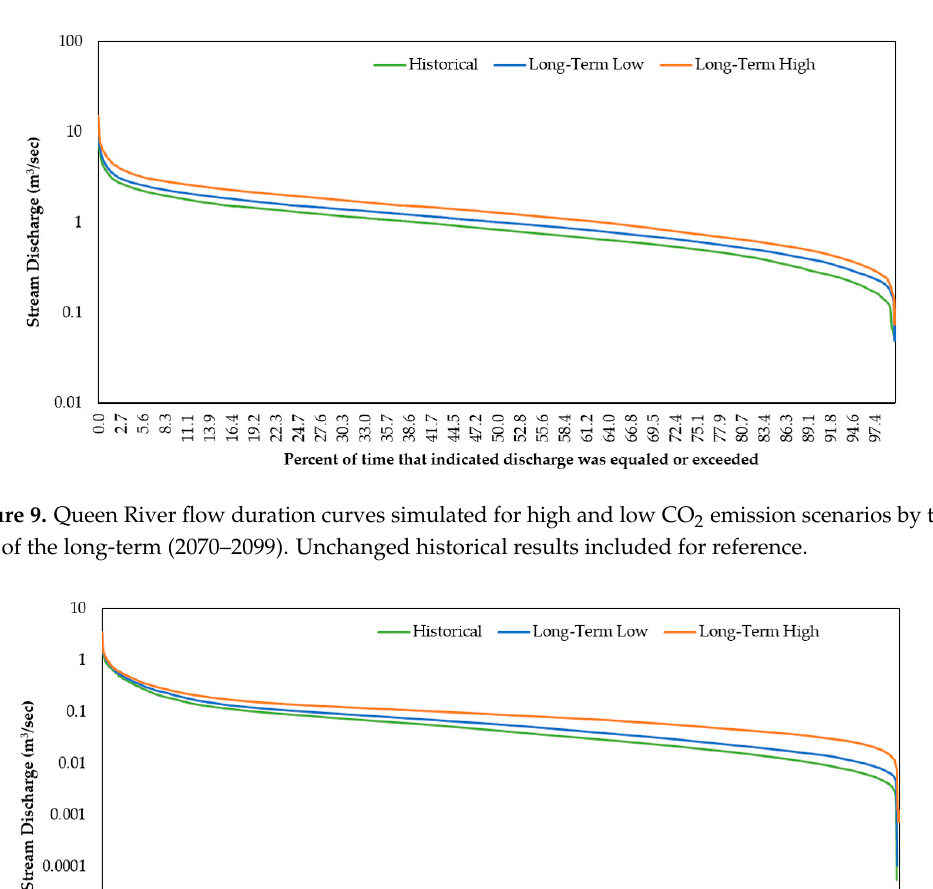
Figure 8. Beaver River flow duration curves simulated for high and low CO 2 emission scenarios by the end of the long-term (2070–2099). Unchanged historical results included for reference.